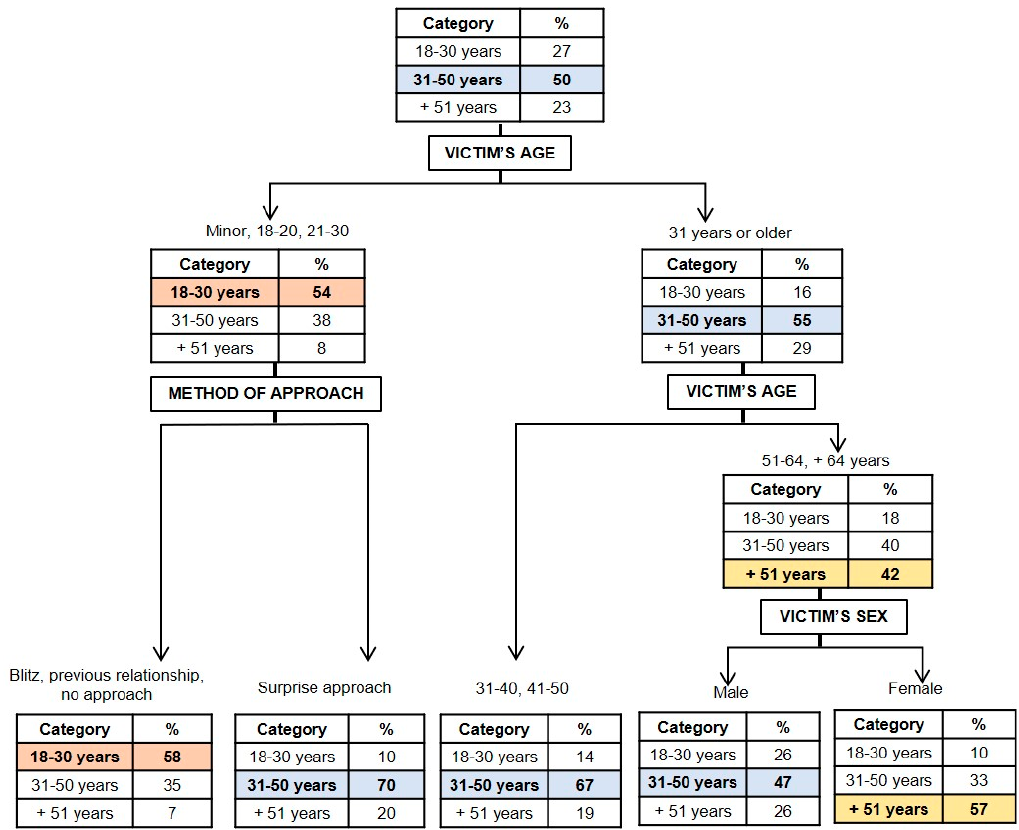
Figure 2. Graphical representation of the classification tree for the perpetrator’s age.